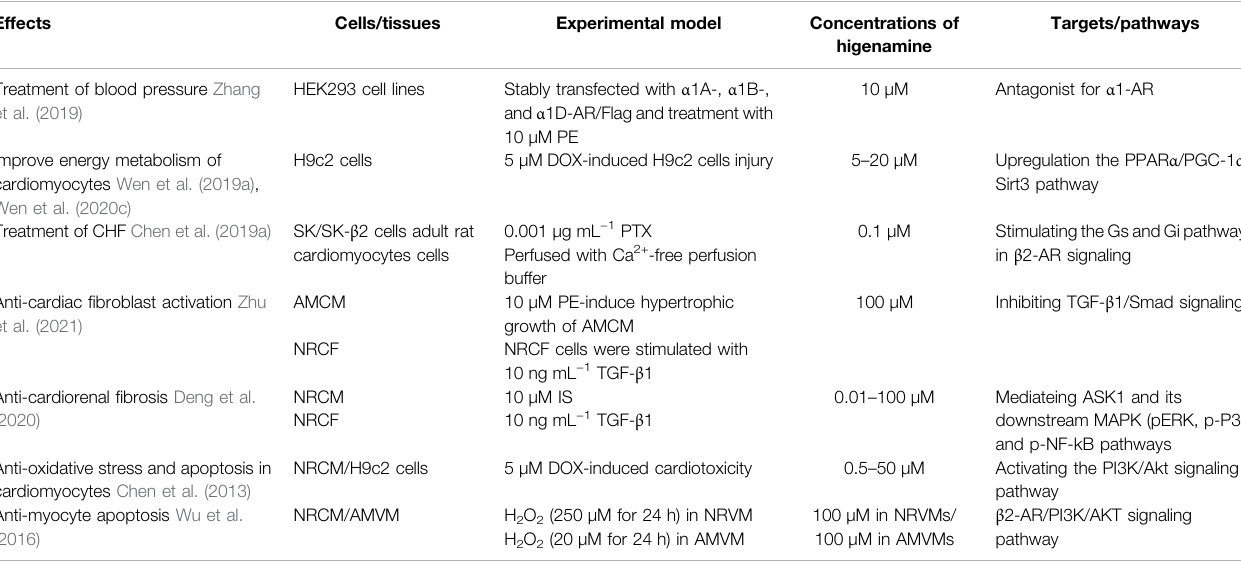
TABLE 3 | In vitro pharmacological activities of higenamine in heart